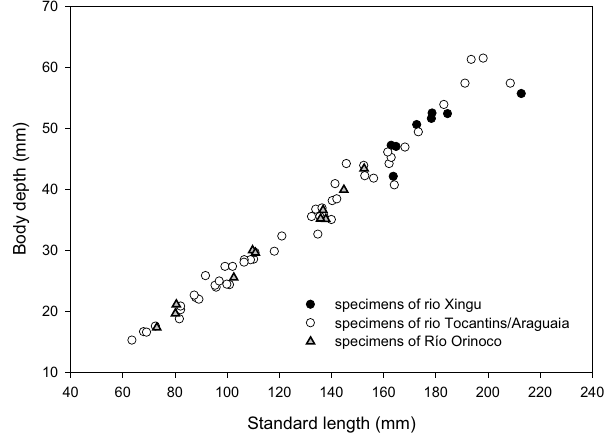
Fig. 11. Scatter plot of body depth on standard length for populations of Laemolyta fernandezi